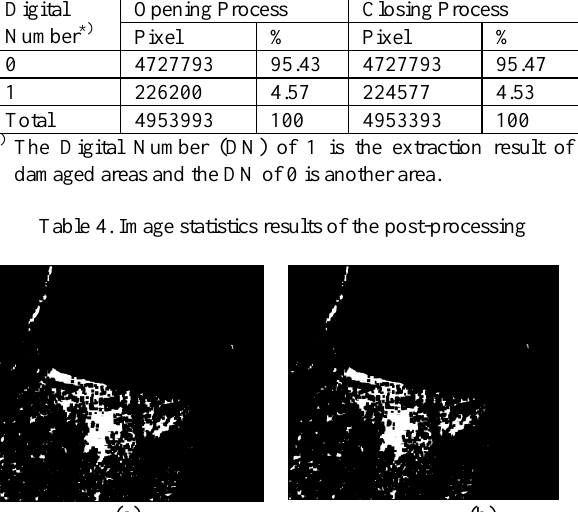
Figure 14. Result images of the contraction and expansion processing: (a) Closing and (b)